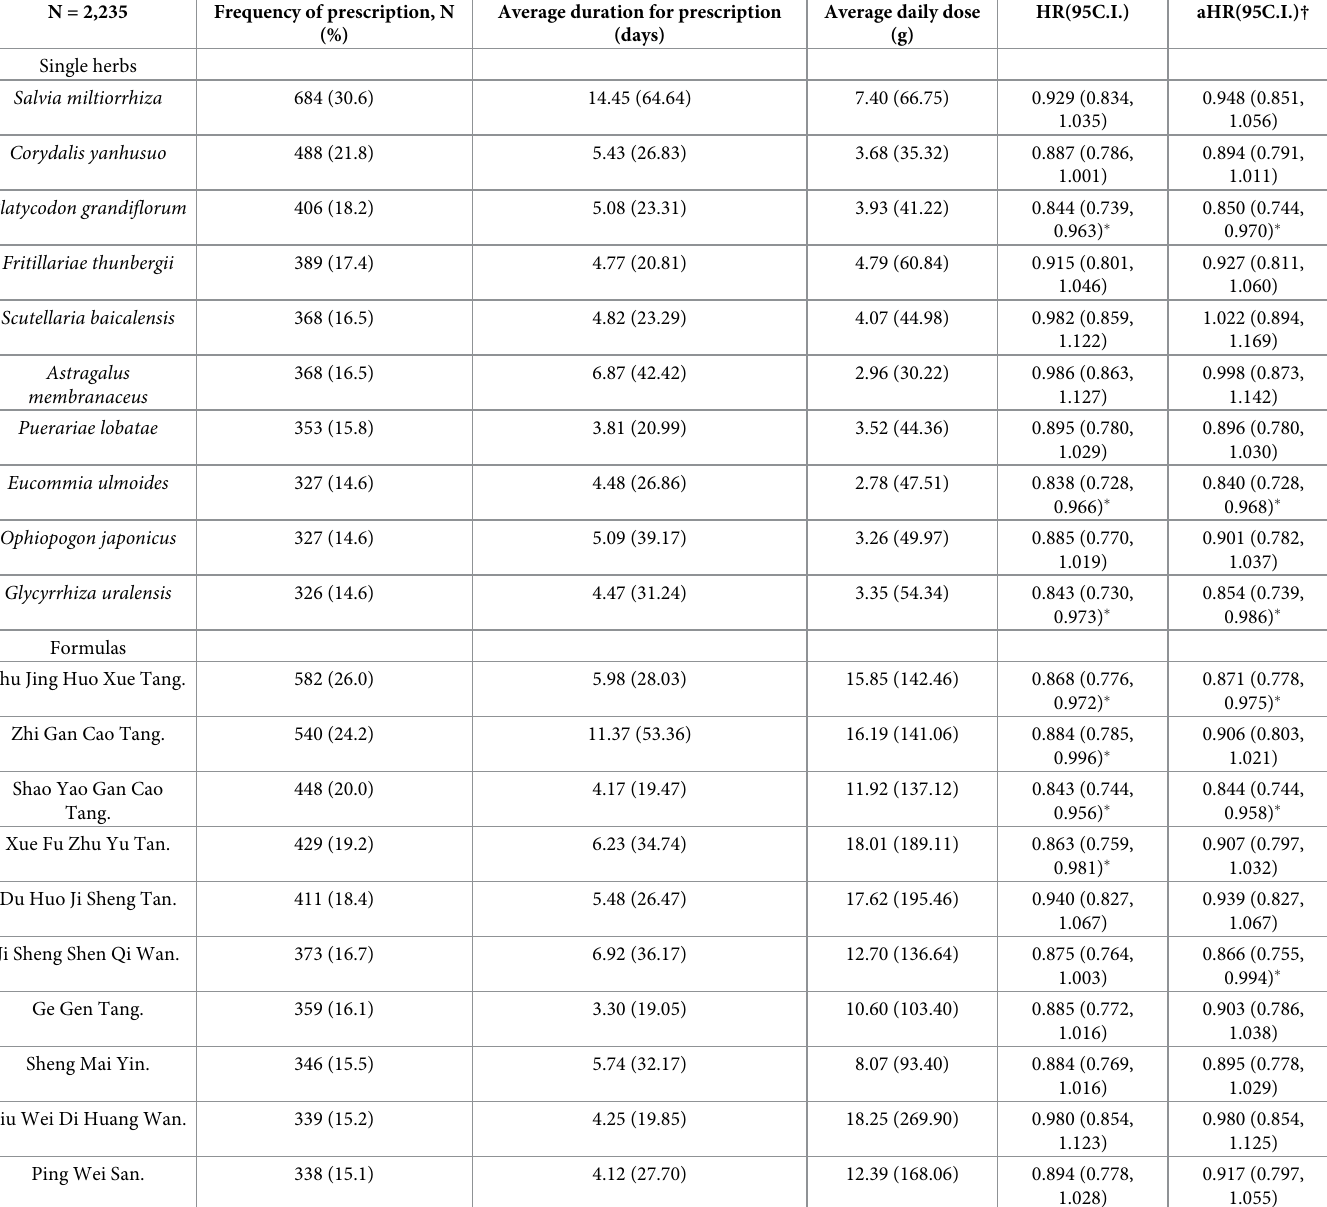
Table 4. Statistics of the top 10 prescribed CHMs with frequency of prescription, average duration for prescription, average daily dose and hazard ratio of major bleeding events between CHM and non-CHM cohort. N =